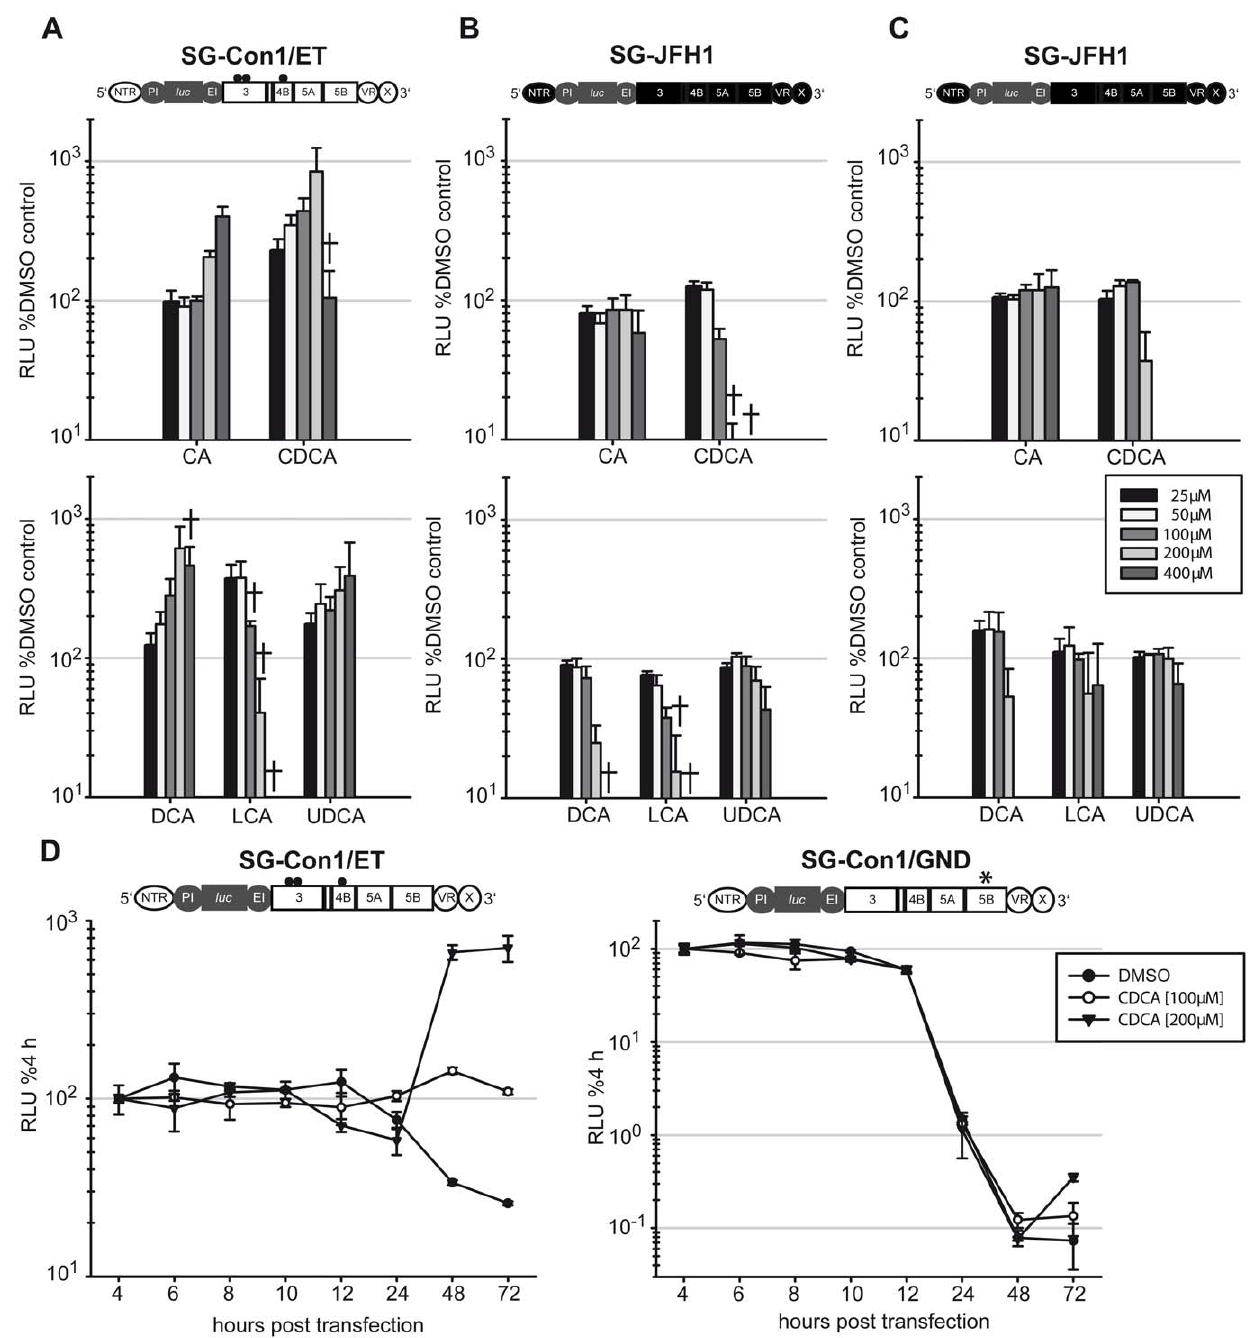
Figure 1. Genotype and cell type dependent influence of bile acids on HCV RNA-replication. Lunet G-luc cells [19] were transfected with either SG-Con1/ET ( A ) or SG-JFH1 replicons ( B ) and seeded on a 96-well plate. After 4 h the medium was changed and different BAs (CA=cholic acid; CDCA=chenodeoxycholic acid; DCA=deoxycholic acid; LCA=lithocholic acid; UDCA=ursodeoxycholic acid) in concentrations ranging from 25 m M– 400 m M were added. 48 h later cell viability was measured by gaussia luciferase assays. The symbol { designates concentrations with a cell viability of less than 50% of the DMSO control. 72 h after electroporation cells were lysed and replication was determined using the firefly luciferase assay. Data were normalized to DMSO control. Con1-derived genome segments are depicted in white, JFH1-derived sequences in black, and non-HCV elements are depicted in grey (PI, polio IRES; EI, encephalomyocarditis virus IRES; luc, firefly luciferase). ( C ) HuH6 cells were transfected with JFH1 replicon RNA and seeded on a 96-well plate. After 4 h, BAs were added and after 72 h cells were lysed and replication was measured using the firefly-luciferase assay. D: Lunet G-luc cells were transfected with Con1/ET (left panel) or Con1/GND (right panel) replicons and seeded on a 12-well plate. Bile acids or DMSO were added 4 h after electroporation. Cells were lysed at given time points; luciferase activity was determined and normalized for the 4 h value. In each case mean values of triplicates and the standard deviation is given.